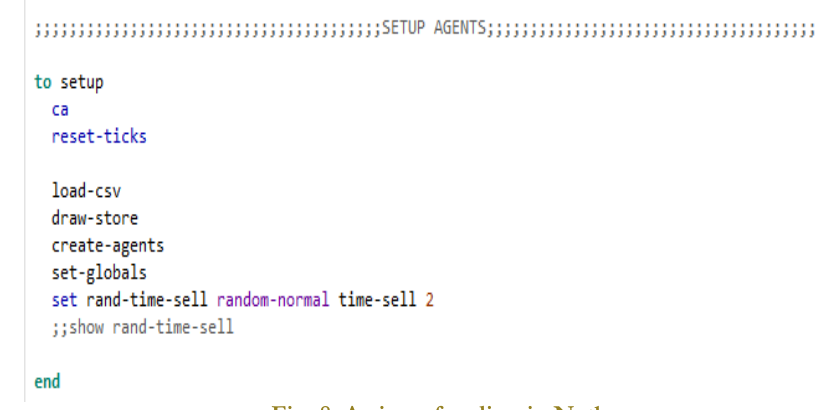
Fig. 8. A view of coding in Netlogo.